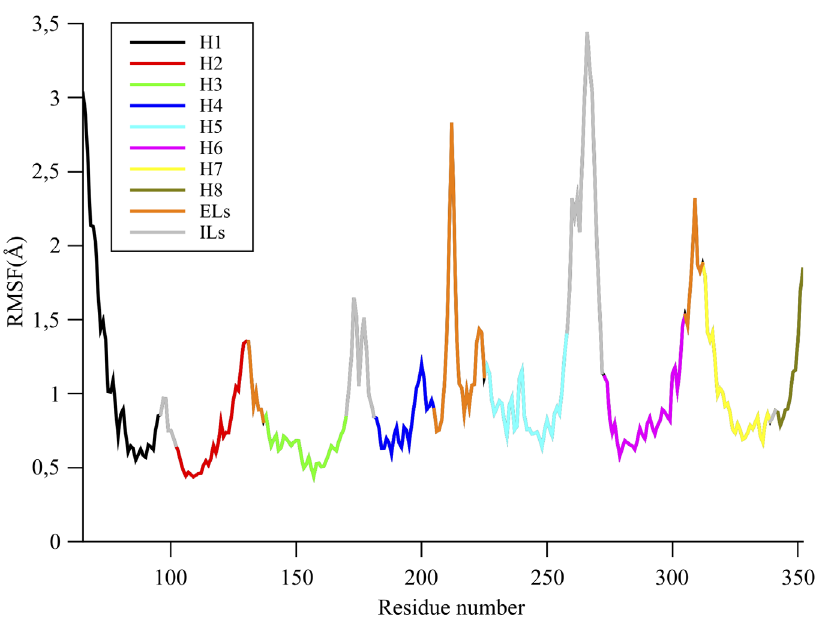
Fig. 5. Root Mean Square Fluctuation (RMSF) of the C a atoms along the m OR structure computed during the 0.5 m s all-atom MD production. Color codes of ILs, ELs, and Hs are the same as in Figure 1.